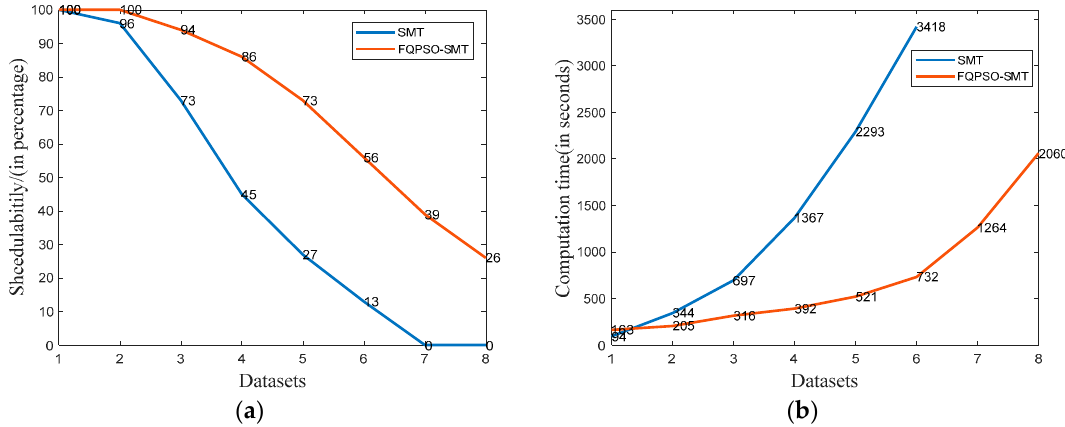
Figure 8. ( a ) Schedulability of SMT and FQPSO-SMT algorithms. ( b ) Computation time of SMT and FQPSO-SMT algorithms.